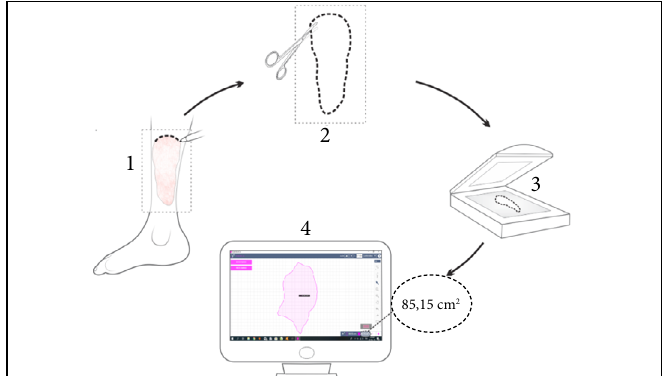
Figure 1 - Measurement of wounded areas. (1) Decal of lesion contours using transparent acetate film; (2) Clipping of the demarcated area, obtaining a two-dimensional pattern (template); (3) Digitalization; (4) Computerized measurement of the injured